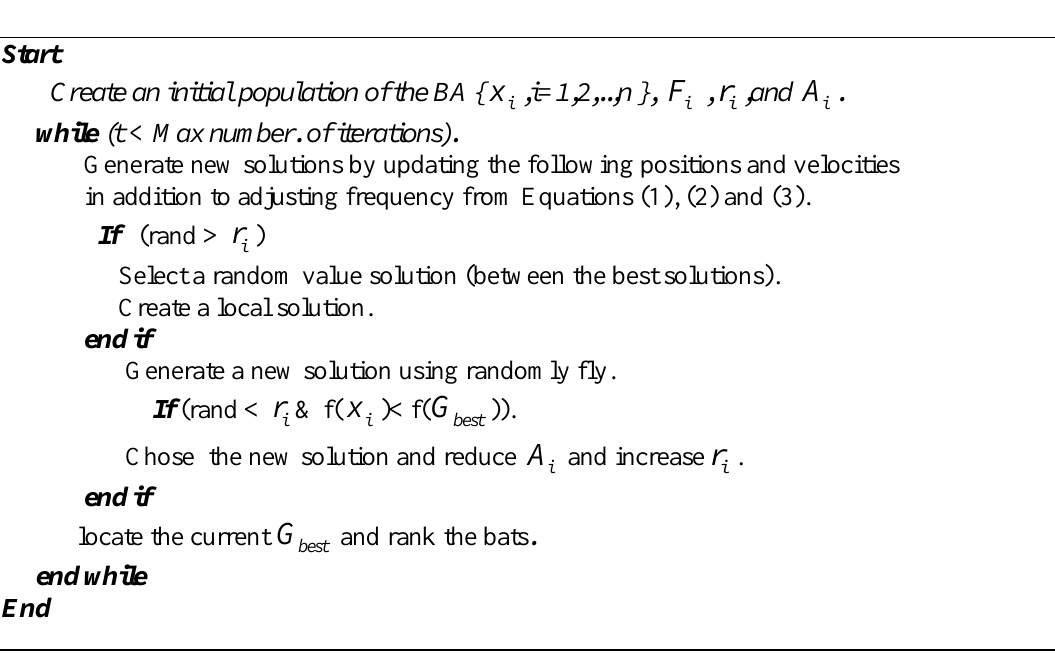
Figure 1. The pseudocode of the